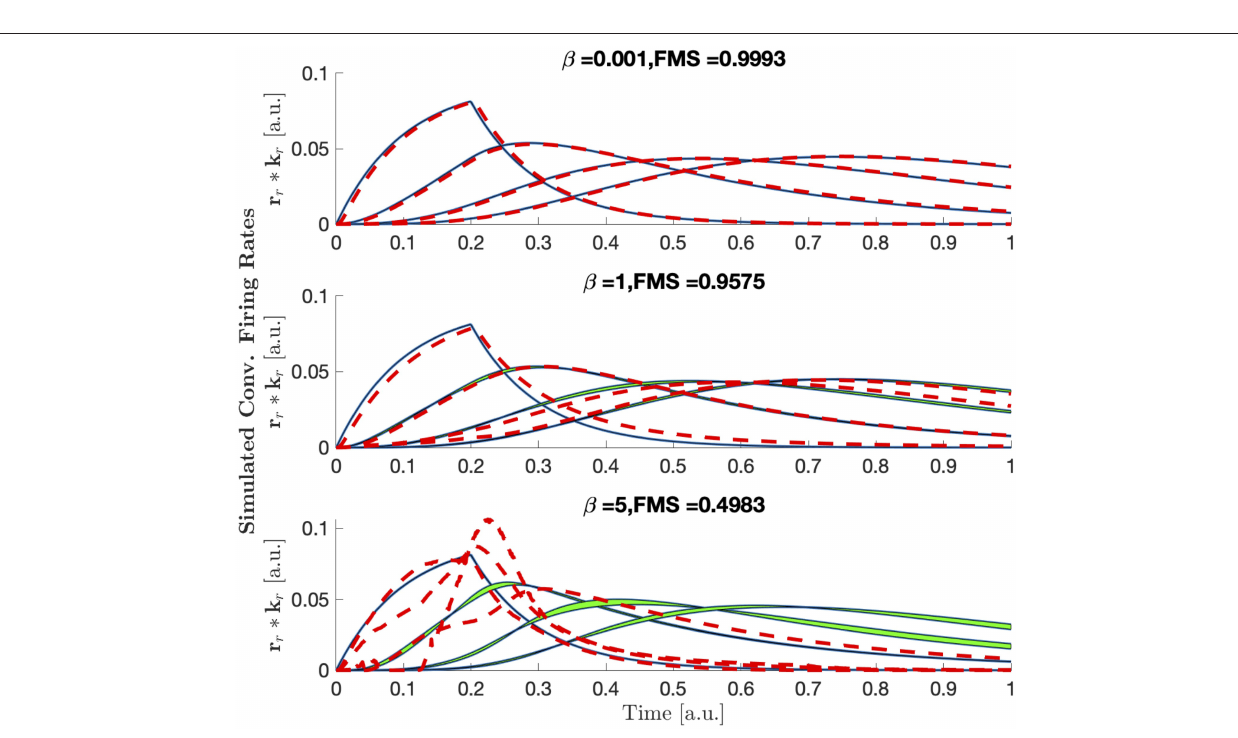
FIGURE A3 | Same as Figure 7 , but with bounded CP to positive values in the firing rate and trial components. Note that for small non-linearities, the temporal components are almost identical for constrained and unconstrained CP, while for strong non-linearities, where CP fails, the components are very